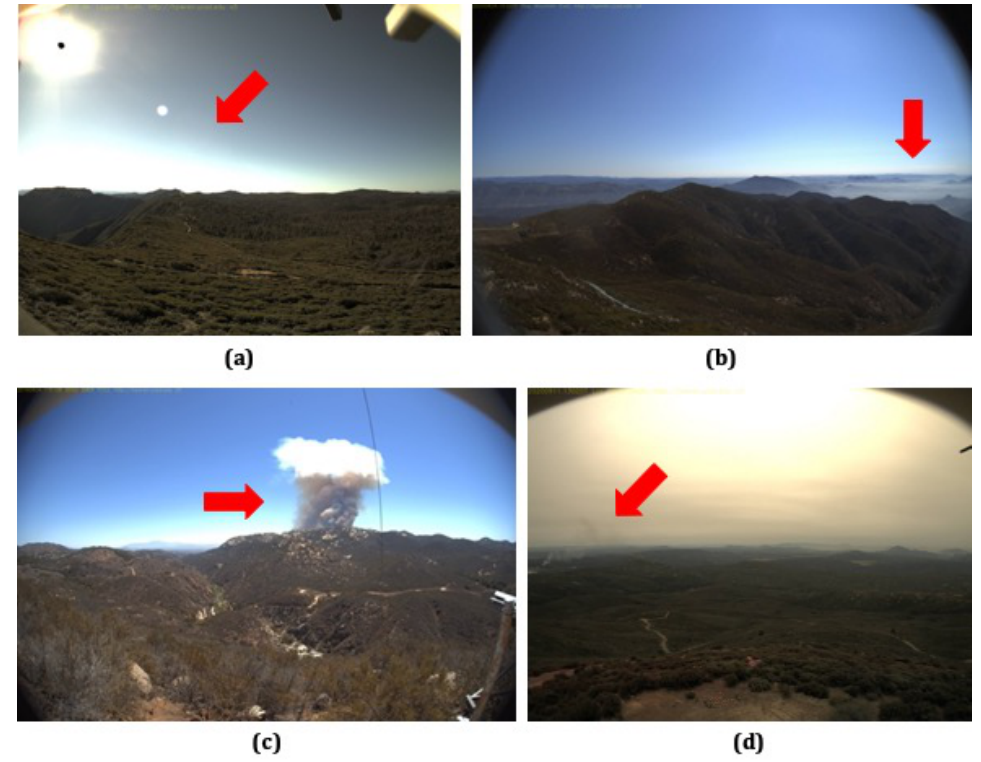
Figure 1. Images from the FIgLib dataset: ( a ) no smoke with strong glare, ( b ) no smoke with misleading haze, ( c ) very apparent wildfire smoke, and ( d ) faint wildfire